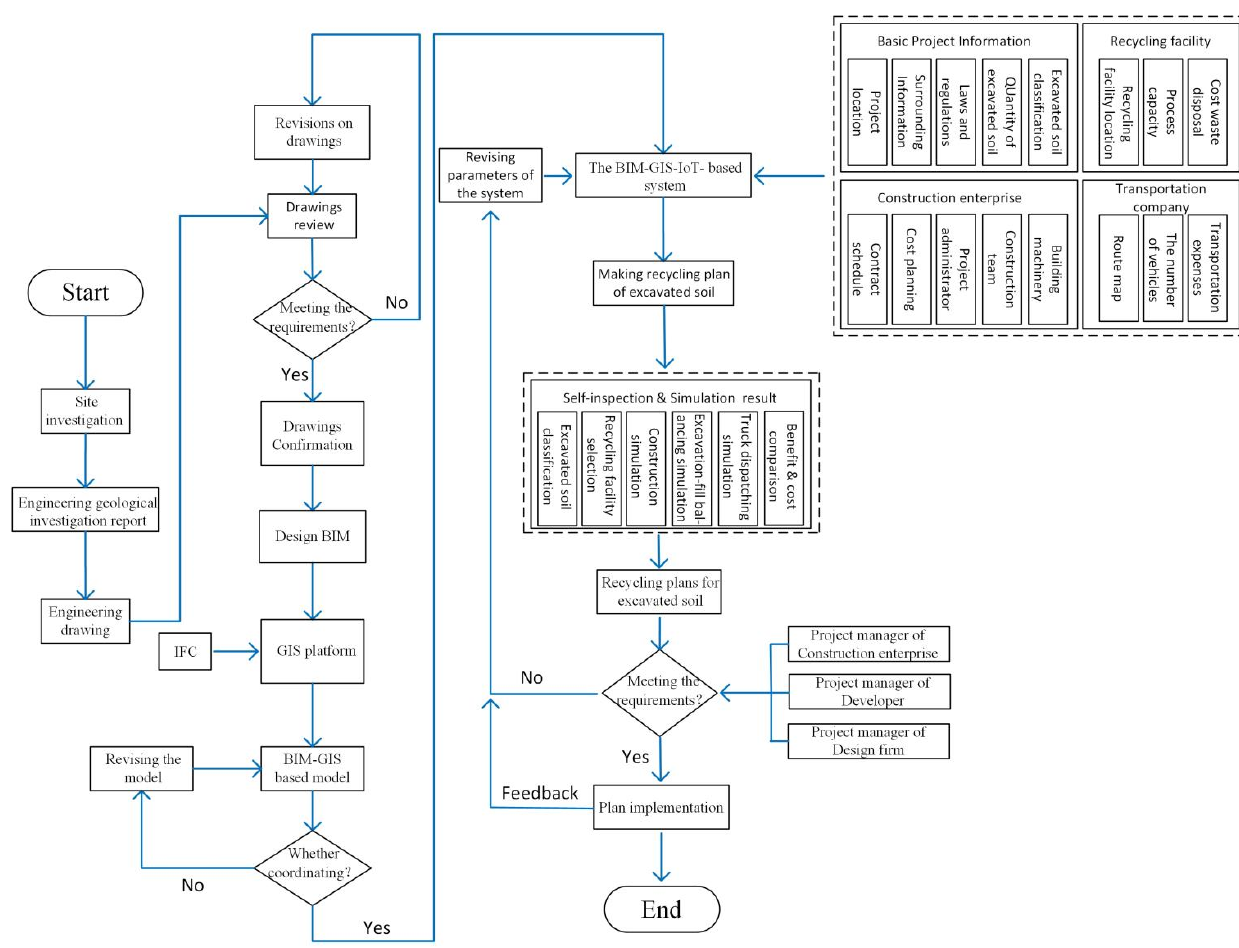
Figure 3. The workflow of BIM-GIS-IoT-based excavated soil recycling system.